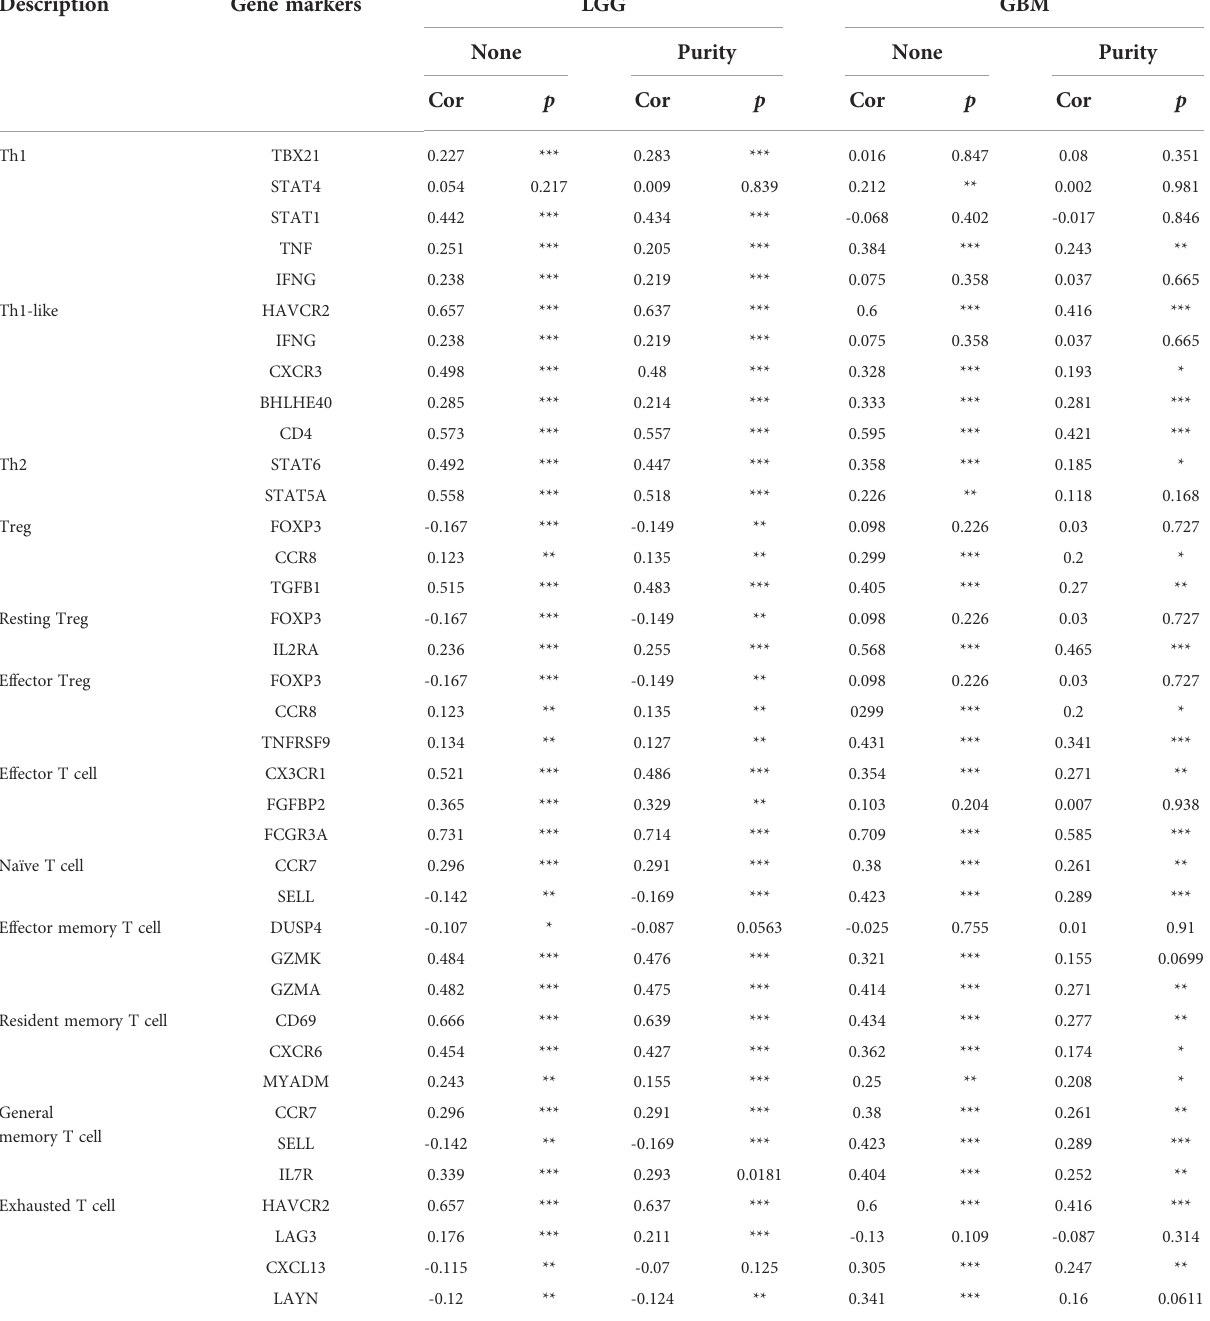
TABLE 2 Correlation analysis between hepcidin and gene markers of different types of T cells in LGG and GBM in TIMER.